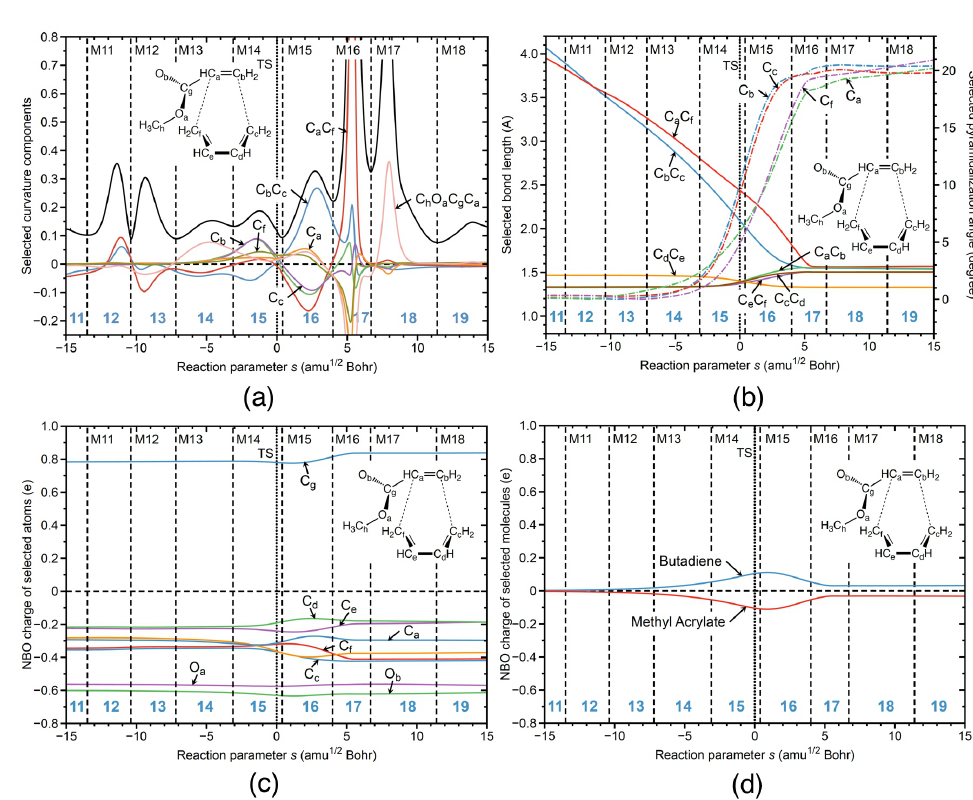
Figure 7. R1ng reaction properties along the reaction path; ( a ) decomposition of the reaction curvature into selected components; ( b ) change of the selected geometrical parameters; ( c ) change of the NBO charges of selected atoms; ( d ) change of the NBO charges of selected molecules. B3LYP/6-311+G(2d,p) level of